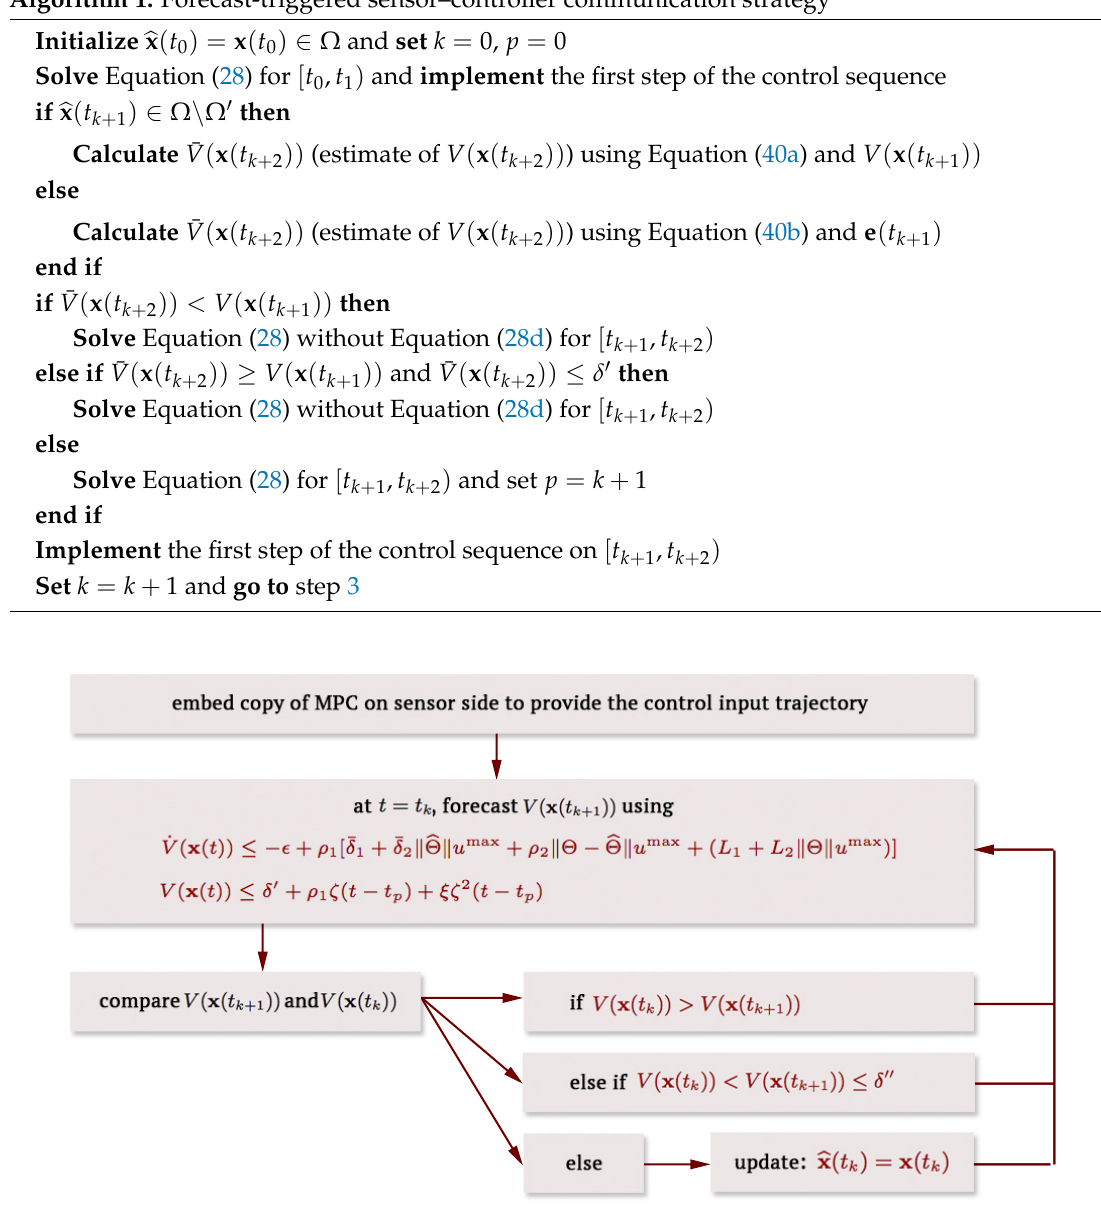
Figure 1. Flowchart of implementation of the forecast-triggered communication strategy. MPC: model predictive